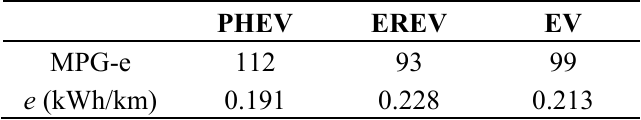
Table 2. Vehicle energy consumption using